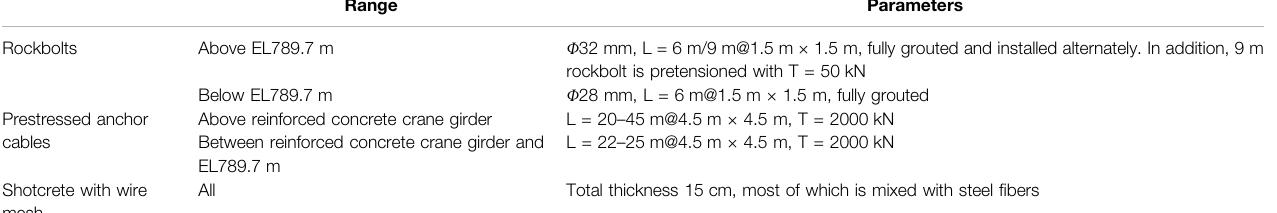
TABLE 1 | Systematic support parameters for the main powerhouse.